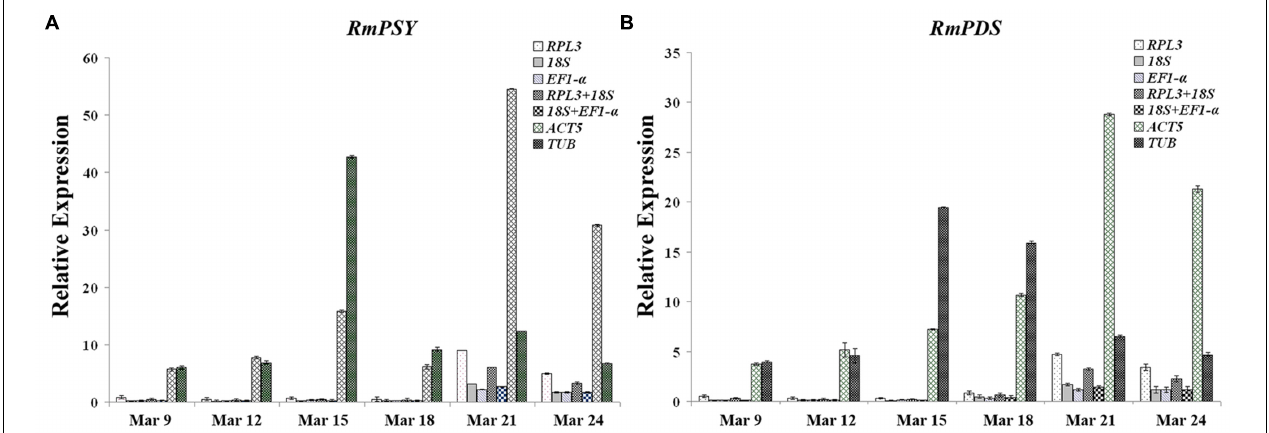
FIGURE 5 | Expression levels of RmPSY and RmPDS throughout the flower development of R. molle . (A) Expression levels of RmPSY at different stages of flower development. (B) Expression levels of RmPDS at different stages of flower development. Genes were normalized to different reference genes. Error bars show the standard error calculated from three biological